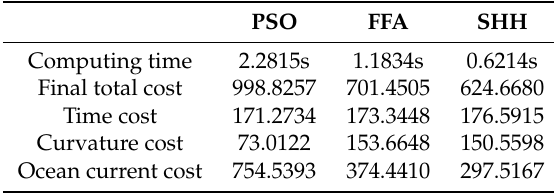
Table 2. Results comparison using PSO, FFA and SHH algorithms in Scenario